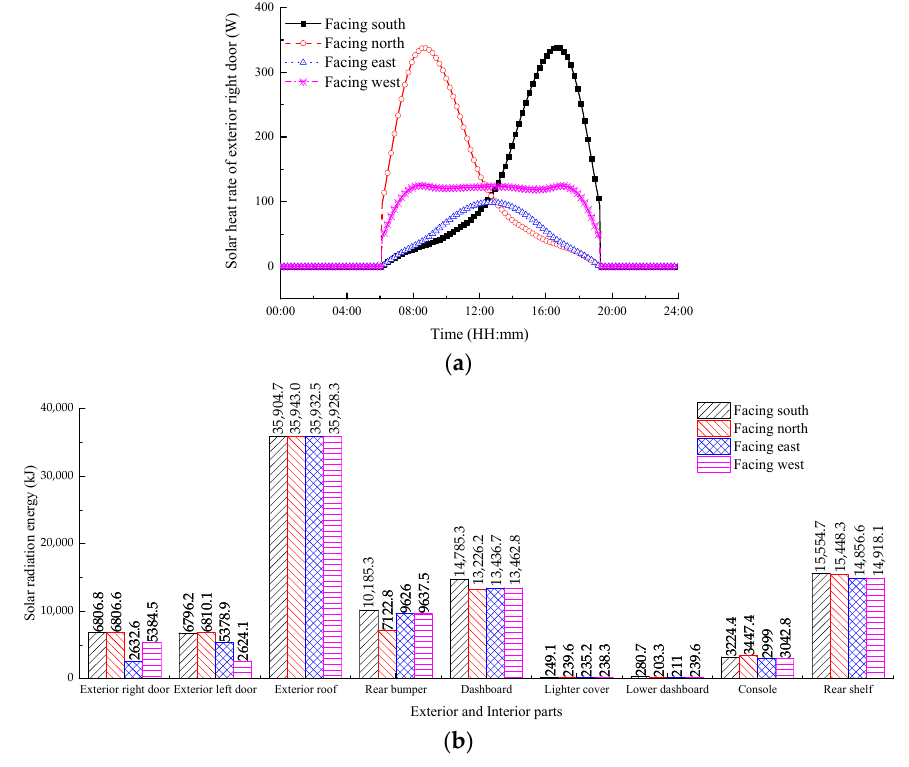
Figure 15. Influence of orientations on the distribution and cumulative values of auto-parts weathering external factors: ( a ) the all-day solar heat rate on the exterior right door; and ( b ) distribution and cumulative values of solar radiation energy on exterior and interior parts.